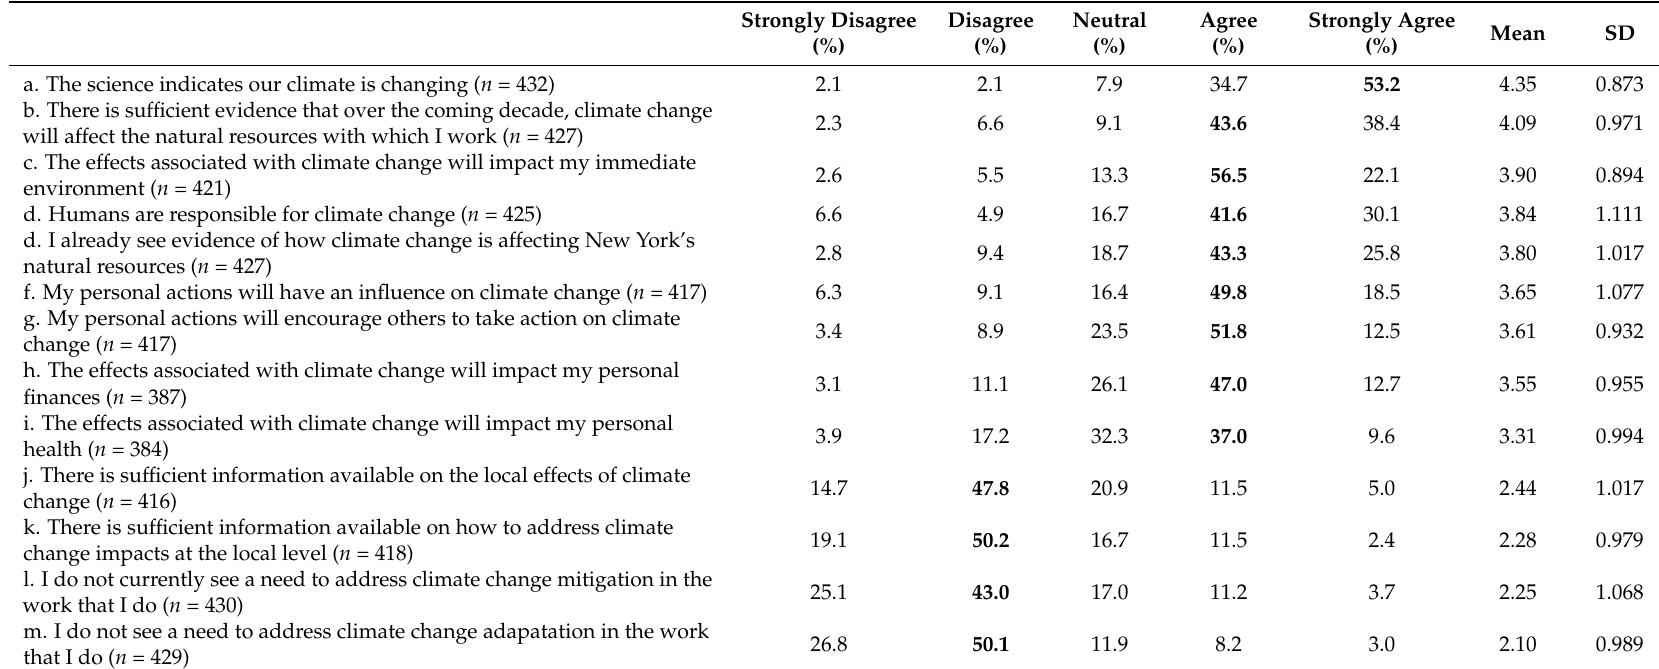
Table 4. Respondents’ climate change attitudes, sorted by mean score on